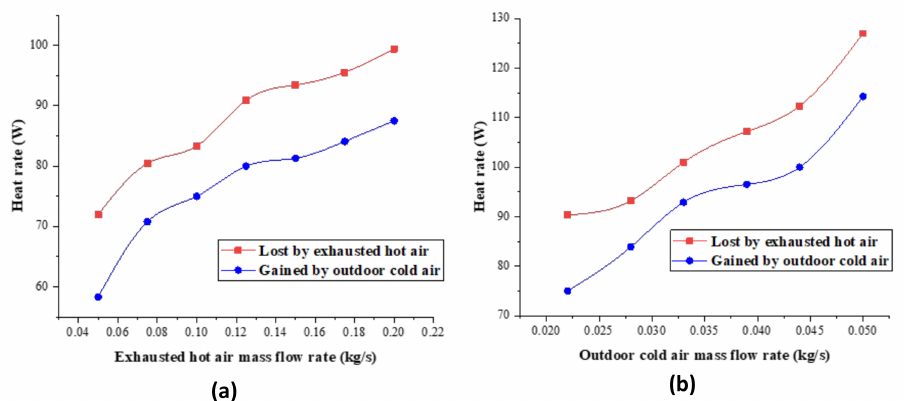
Figure 4. ( a ) Hot air lost heat rate and cold air gained heat rate in terms of the hot air flow rate (test